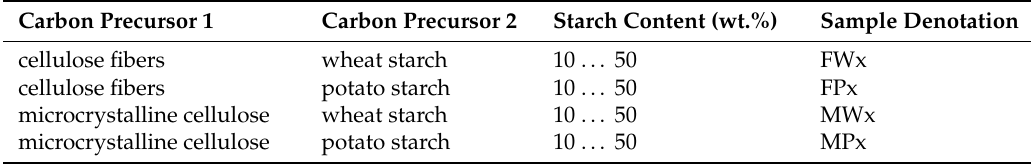
Table 1. Composition of the used carbon precursor